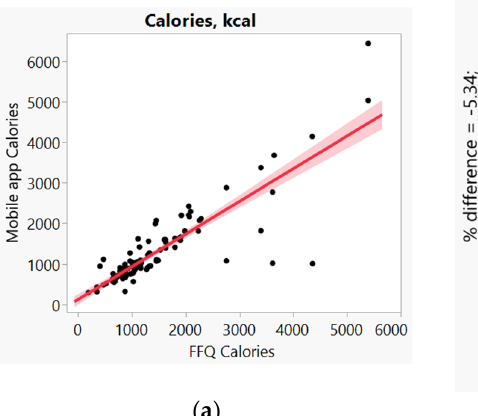
Figure 1. ( a ) Correlation, ( b ) Bland and Altman plots between mobile application and Food Frequency Questionnaire (FFQ) on total calories.